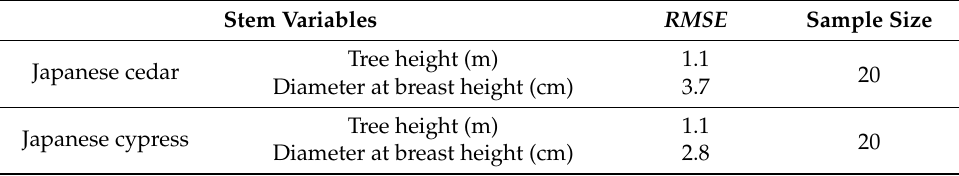
Table 2. Accuracy of the forest parameters derived from airborne lidar data of Ibaraki Government. Stem Variables RMSE Sample